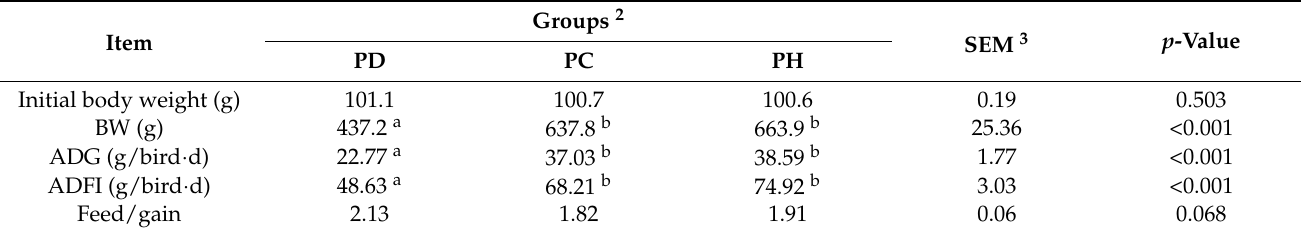
Table 3. Effects of dietary phosphorus (P) deficiency and high P content on growth performance of